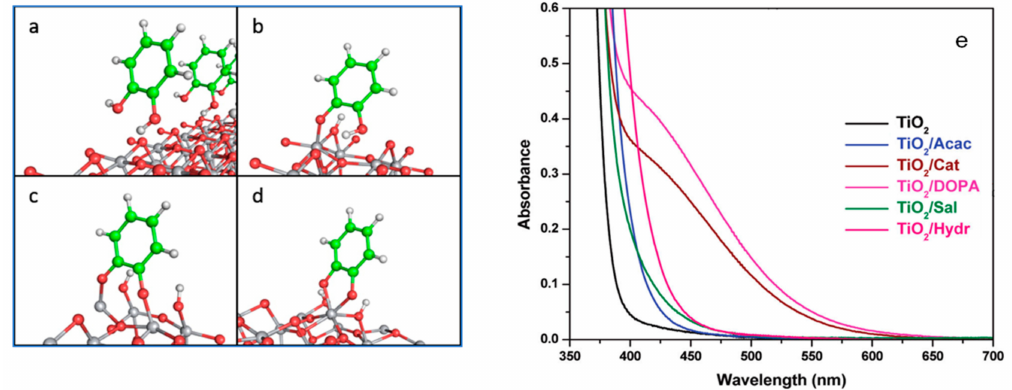
Figure 6. Geometries of Ti-catechol complexes at TiO 2 anatase (101) surface: ( a ) molecular adsorption, ( b ) monodentate, ( c ) bidentate bridging, ( d ) bidentate chelating coordination; ( e ) UV-visible absorption spectra of TiO 2 nanoparticles sensitized by acetylacetone (Acac), catechol (Cat), dopamine (DOPA), salicylic acid (Sal), and hydroxamic acid (Hydr). Adapted and reprinted with permissions from [104] and [101], Copyright (2012 and 2016) American Chemical Society